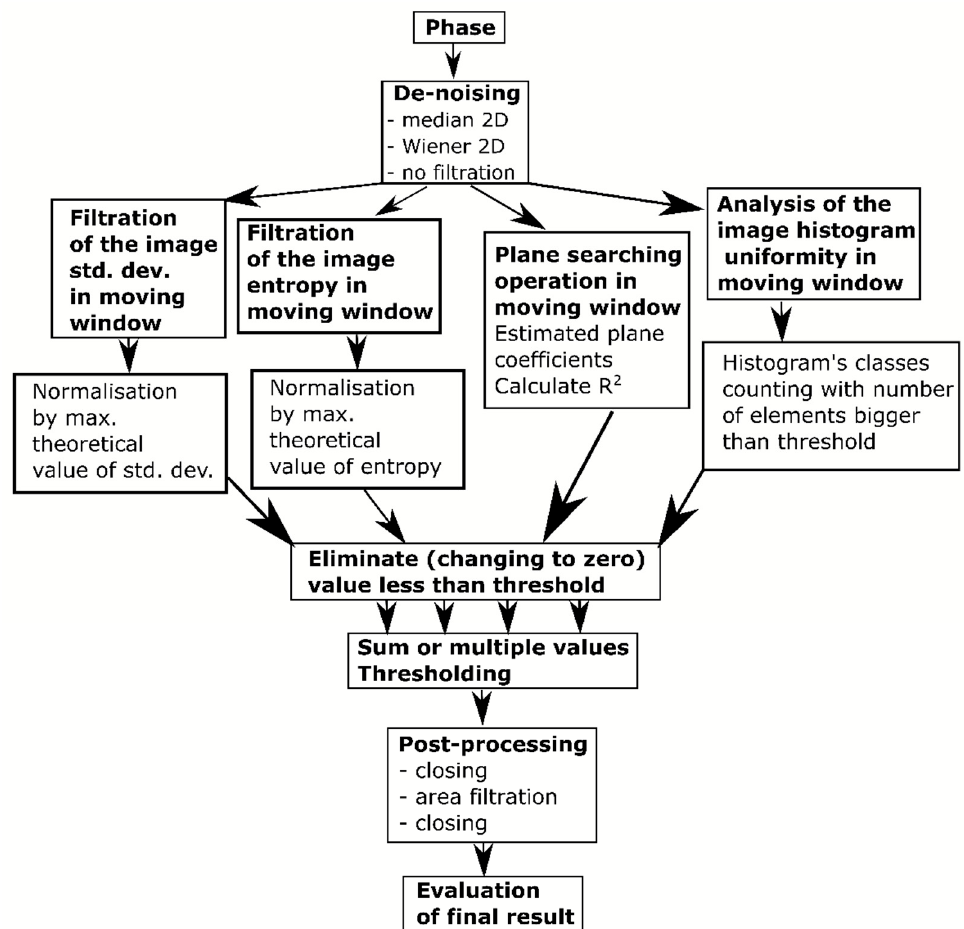
Figure 3. Working principle of the algorithm detecting subsidence troughs in interferometric images.